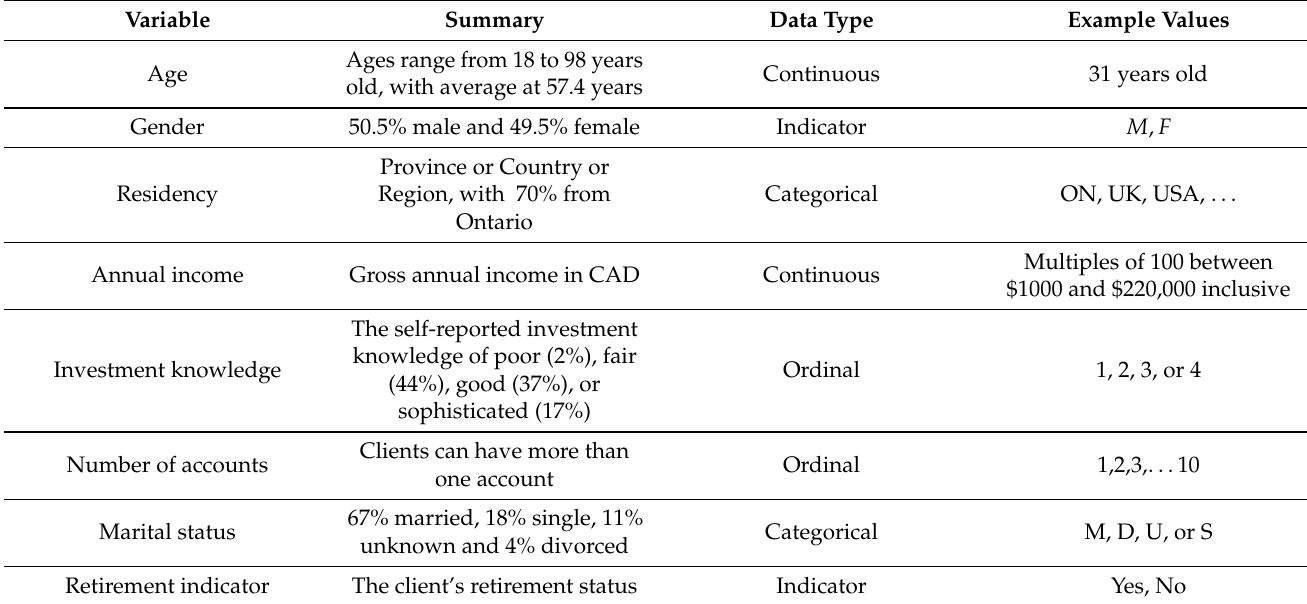
Table 1. Details of variables from clients’ KYC